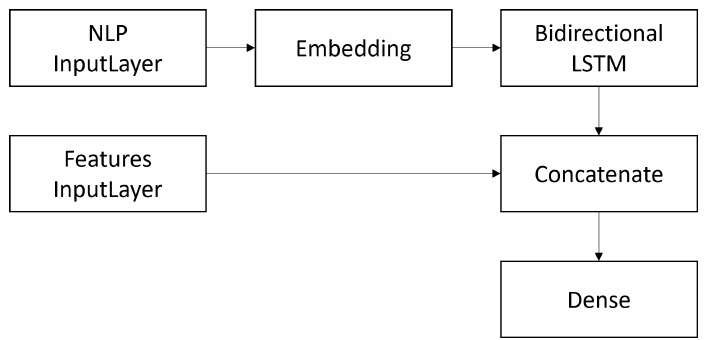
Figure 3. Architecture of the Bidirectional LSTM